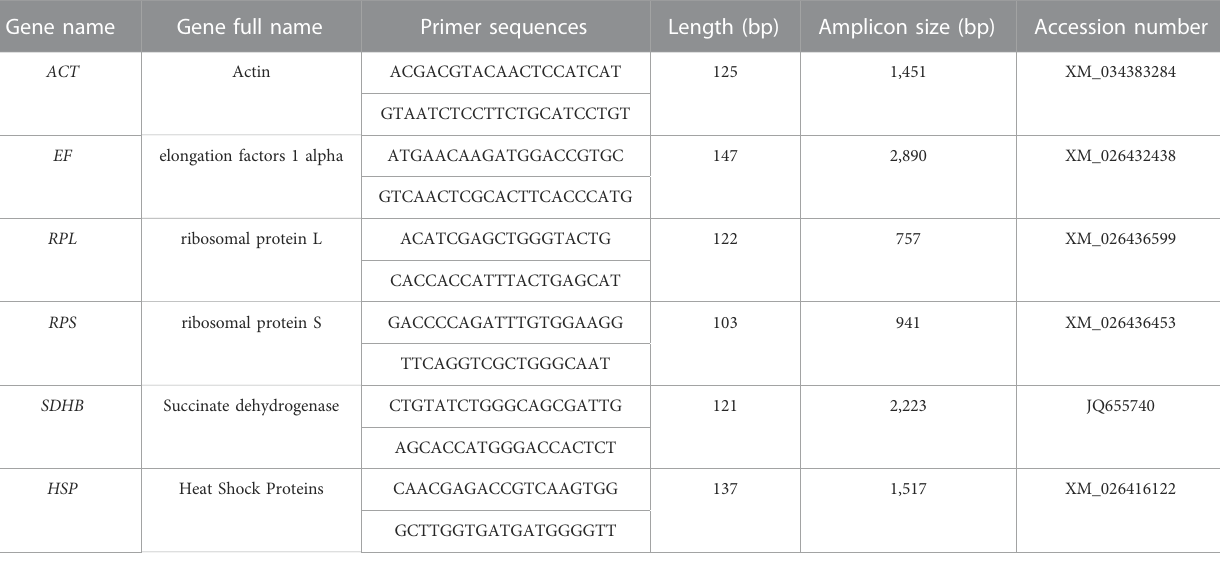
TABLE 1 Information of primers used for